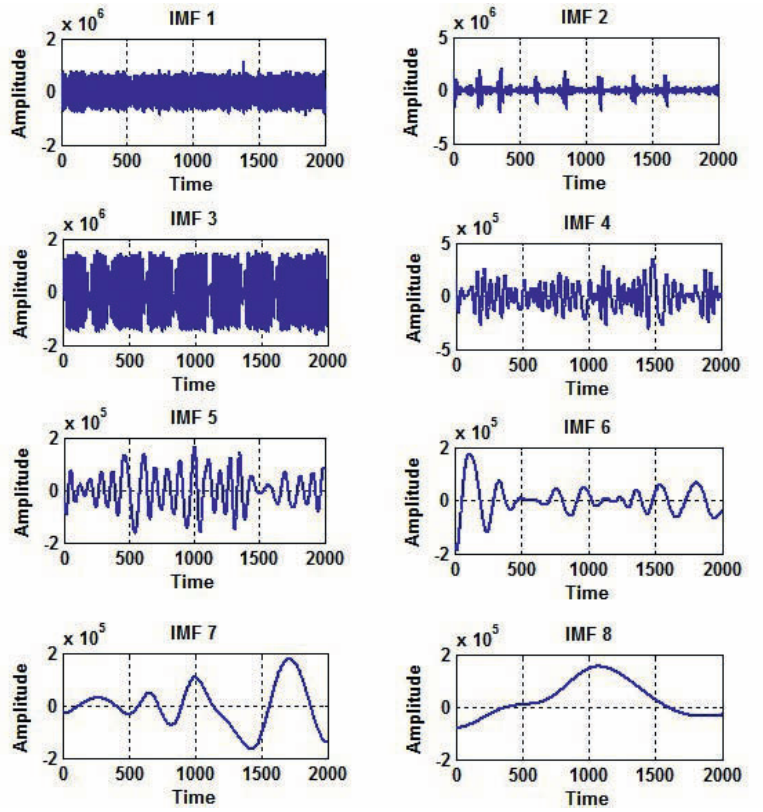
Figure 8. IMFs of noisy